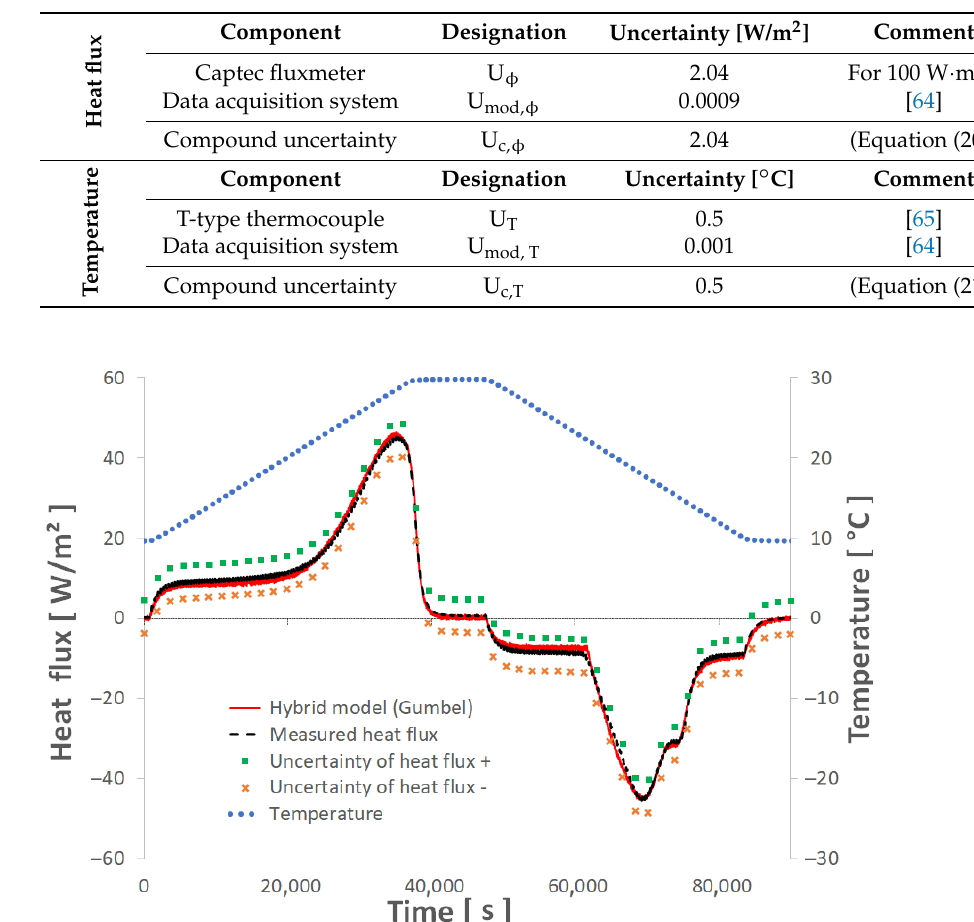
Figure 21. Uncertainties of heat flux measurement on the ETMV 8 coating.